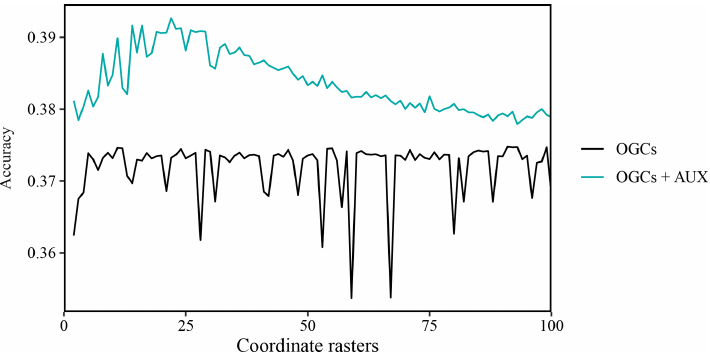
Figure A3. Accuracy (percent of cases correctly predicted) of predictions on the eberg dataset versus the number of coordinate rasters with oblique geographic coordinates (OGCs), with and without auxiliary data (AUX). The values are averages obtained with 100 splits into training and test